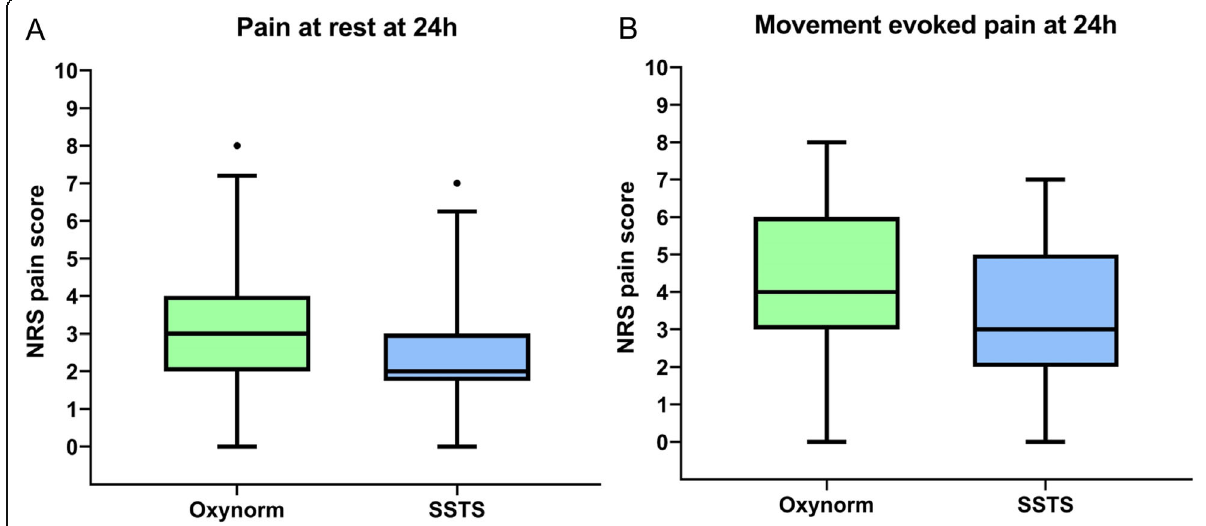
Fig. 2 Box and whisker plots of postoperative pain score at 24 h a . Pain score at rest. b . Dynamic pain score. Solid horizontal lines represent the median, boxes indicate interquartile range (Q25-Q75), whiskers represent 5th percentile and 95th percentile and dots are the extreme values. No statistical difference was